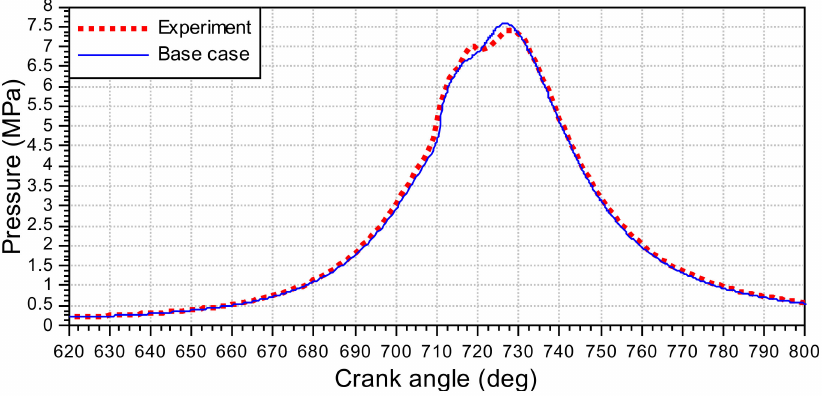
Figure 2. Calculated and experiment pressure curves for biodiesel in an operated diesel engine at 1450 rpm and 25% of the full load